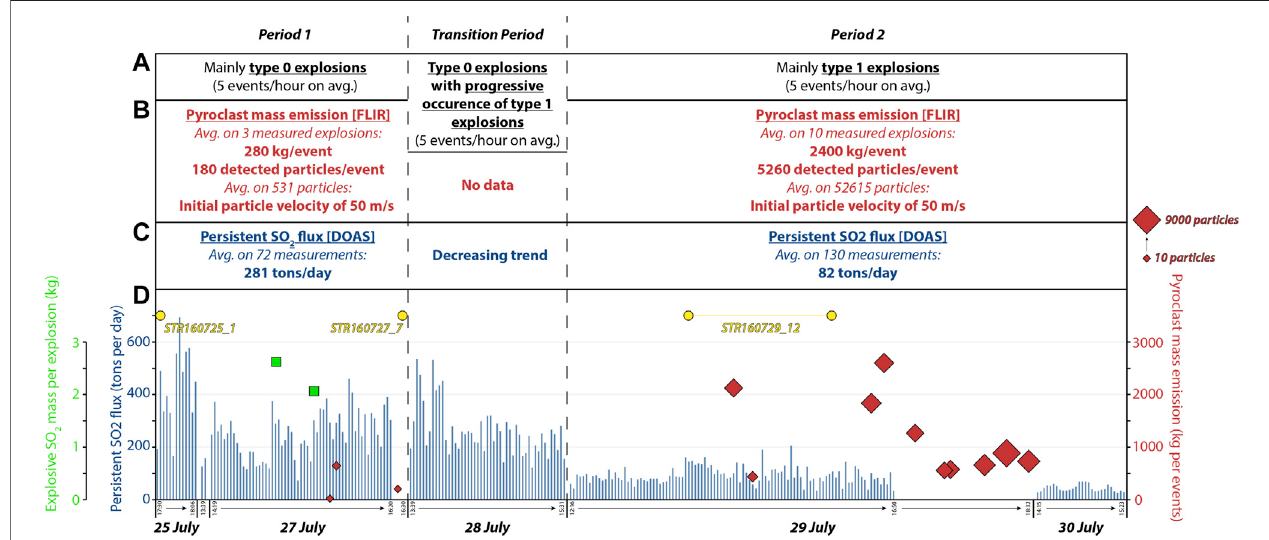
FIGURE 4 | Field experiment results performed between July 25, 2016 and July 30, 2016. (A) Field observations. (B) Summary of the pyroclast mass emissions measuredwiththeForwardLookingInfra-Red(FLIR) camera. (C) Summaryofthepersistent SO 2 fl uxesmeasured withtheDifferential Optical AbsorptionSpectroscopy (DOAS) instrument. (D) Detailed timeline of the performed measurements. Red squares represent the pyroclast mass emissions during type 0 and 1 explosions, calculated from the FLIR acquisitions; the size of the red squares is proportional to the number of the detected particles. Green squares are the two explosive SO 2 measurementsfromtheUltra-Violet(UV)SO 2 camera.YellowcirclesrepresenttheexplosionsrelatedtothethreeexploitableashsamplescollectedbytheASHcollector and sizER (ASHER)